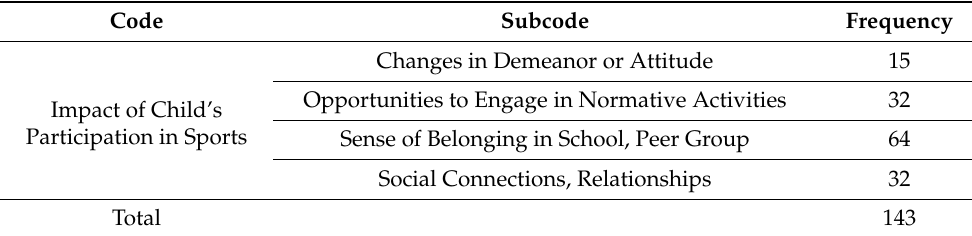
Table 3. Frequency of Thematic